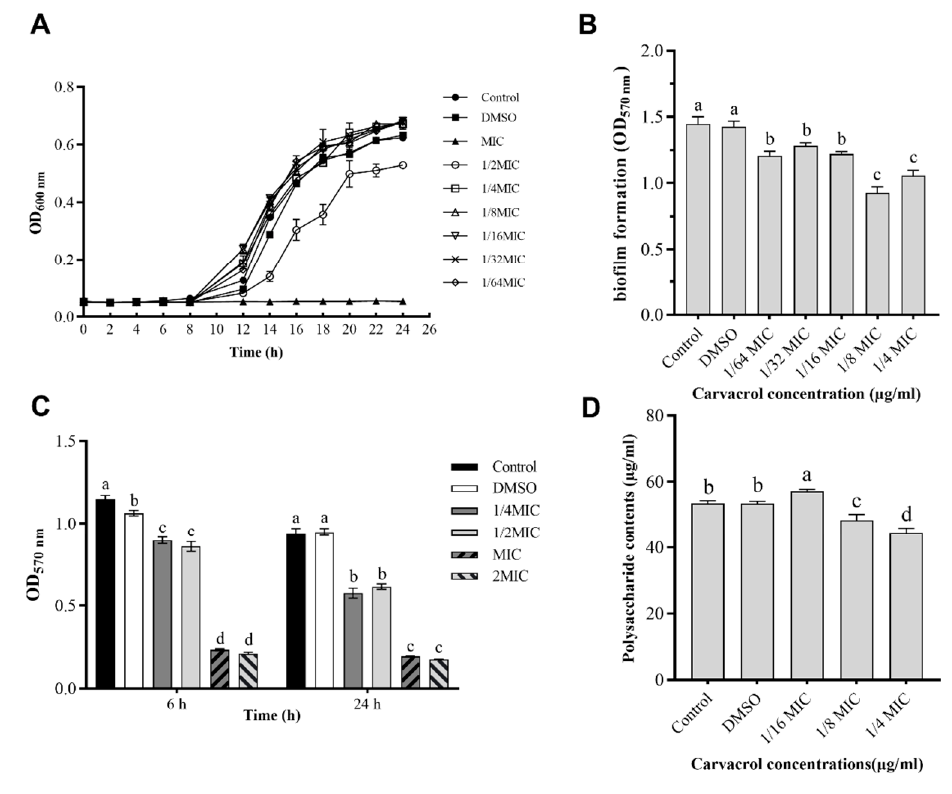
Figure 1. Antibiofilm activity of carvacrol against Aeromonas hydrophila . ( A ). The effect of carvacrol on A. hydrophila growth according to MIC and sub-MICs. Carvacrol concentration: Control (0), MIC (125 µg/ml), 1/2 MIC (62.5 µg/ml), 1/4 MIC (31.25 µg/ml), 1/8 MIC (15.625 µg/ml), 1/16 MIC (7.8125 µg/ml), 1/32 MIC (3.90625 µg/ml), and 1/64 MIC (1.953125 µg/ml). ( B ). The effect of carvacrol on